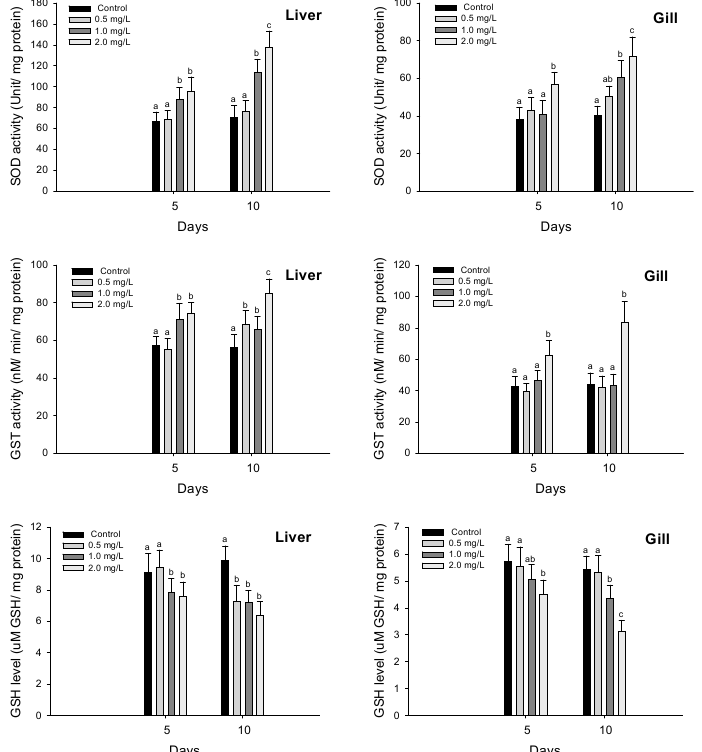
Figure 1. Antioxidant responses of flatfish, Paralichthys olivaceus exposed to the different concentrations of waterborne chromium for 10 days. Values with different superscripts are significantly different in 5 and 10 days ( p < 0.05) as determined by Tukey’s multiple range test.